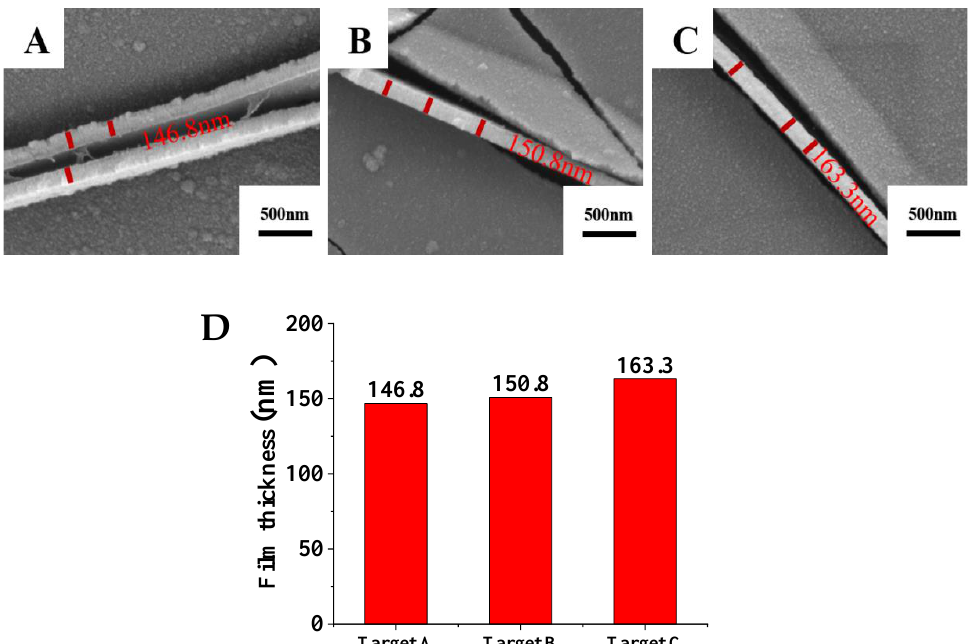
Figure 5. Cross-sectional morphologies and film thicknesses of films prepared from Ti targets with different purities. ( A ) Target A; ( B ) Target B; ( C ) Target C; ( D ) Variation of the film thickness with different purity of targets.